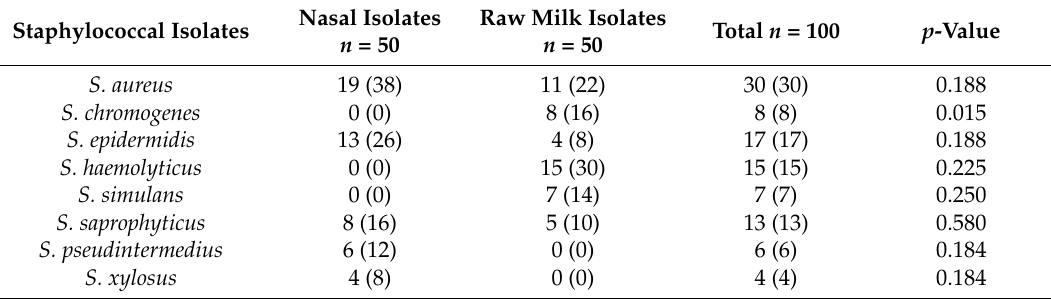
Table 1. Species diversity of staphylococcal isolates recovered from nasal and milk samples. Staphylococcal